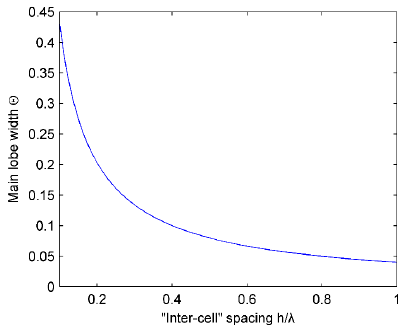
Figure 8. Influence of “inter-cell” spacing h on the width of main lobe Θ .